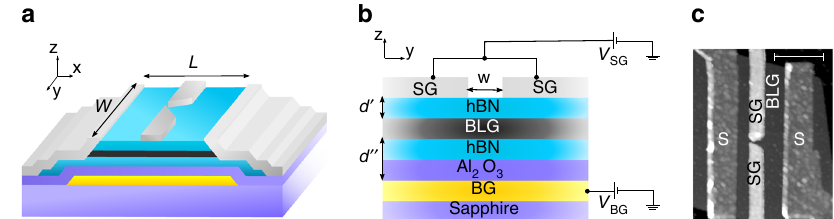
Fig. 1 Device geometry. a 3D Schematics of the device and b cross-sectional view as a cut through the dual-gated region. The device consists of a hBN- BLG-hBN heterostructure (with a bottom and top hBN multilayer of ~35 and ~38 nm thick) on a pre-patterned overall back-gate (BG) covered with a 20 nm thick Al 2 O 3 and a split-gate (SG) on top of the heterostructure. The superconducting leads are edge connected to the mesa. The width W = 3.2 μ m and length L = 950 nm while the distance between the two fi ngers of the split-gate w ~ 65 nm (and d ′ ~ 38 nm and d ″ ~ 55 nm). c AFM image of the device.